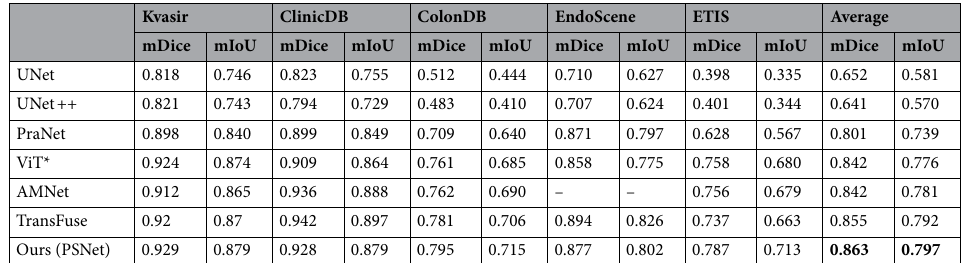
Table 2. Results from comparative studies. Significant values are in